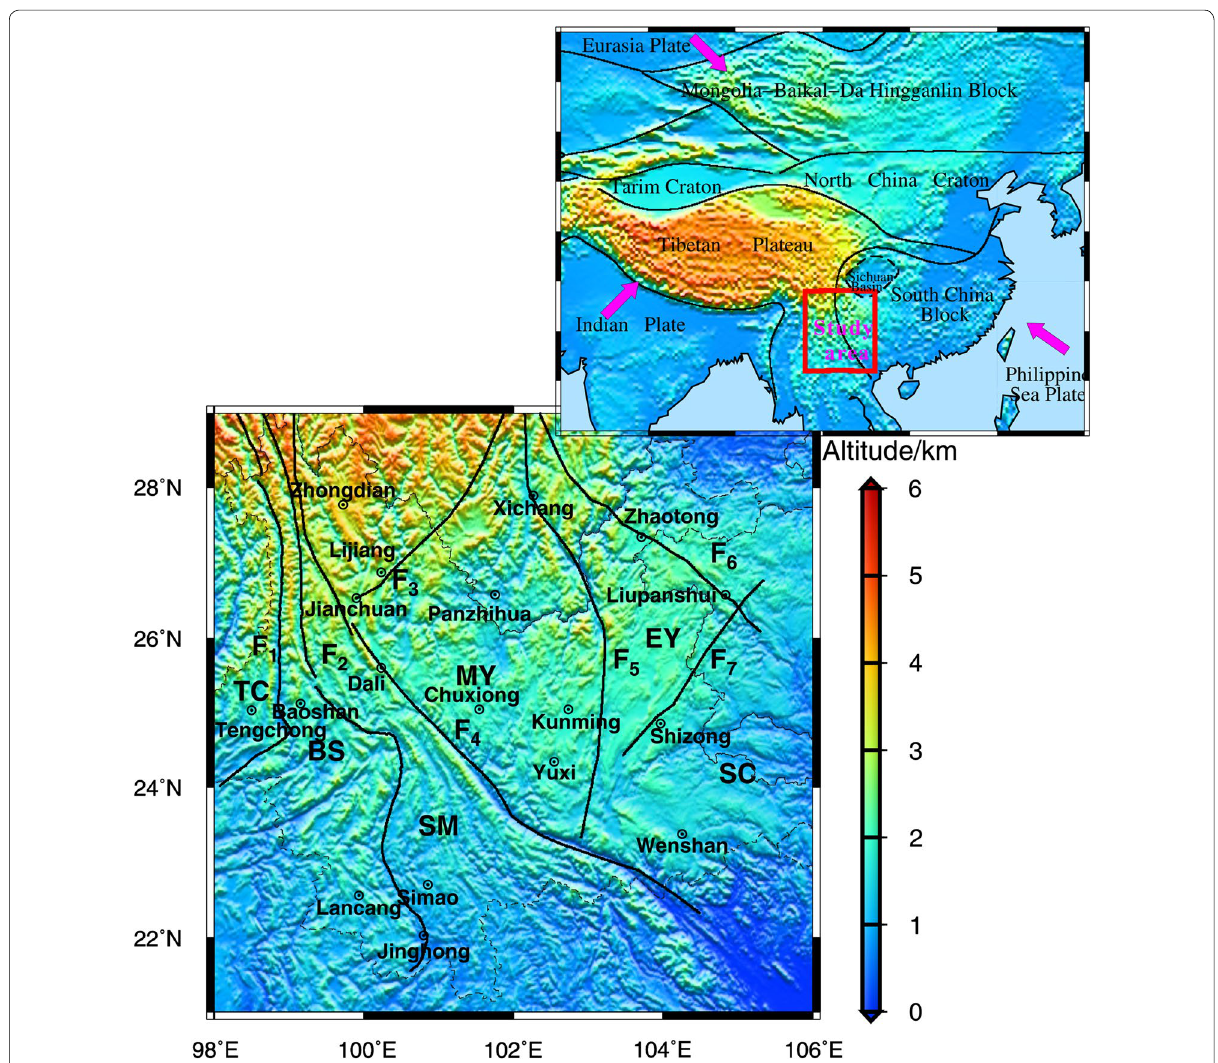
Fig. 1 Topography and tectonics of Yunnan Province, China and its adjacent areas. The small map in the top right corner is modified from Gao et al. (2018). TC—Tengchong block, BS—Baoshan block, SM—Simao Block, MY—Middle Yunnan Block, EY—Eastern Yunnan